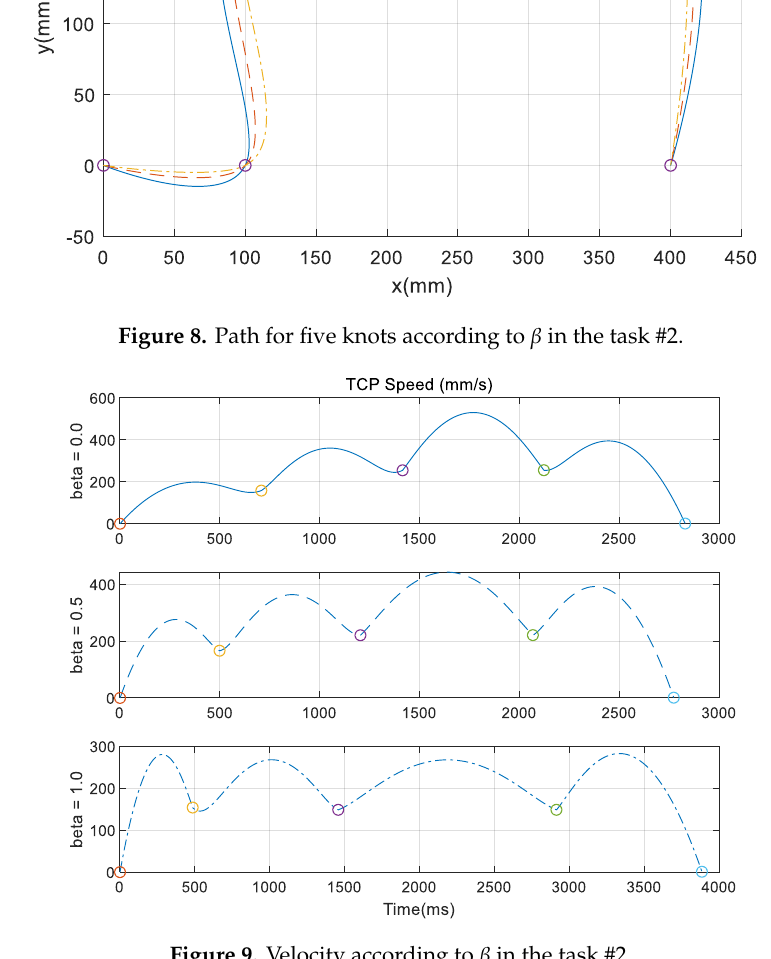
Figure 9. Velocity according to β in the task #2.